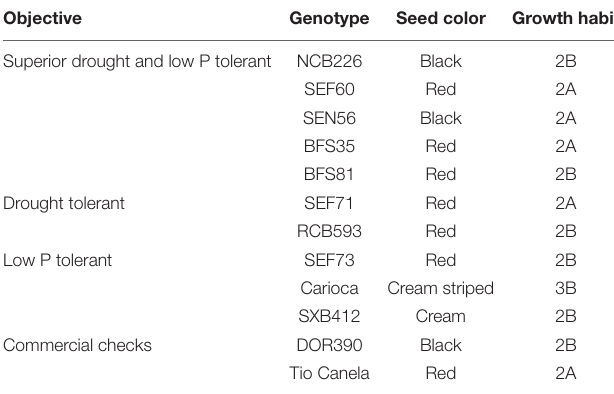
Growth habit classification is explained in the